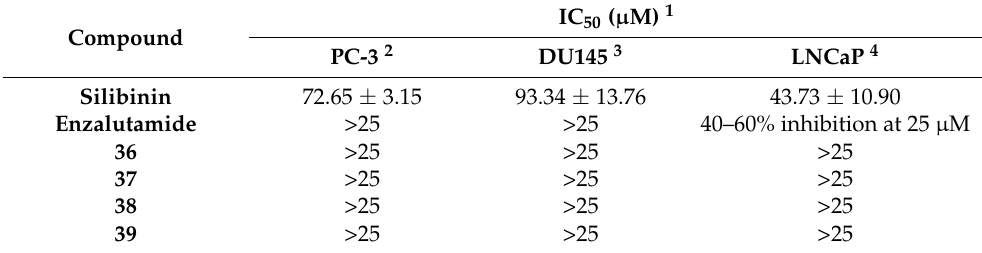
Table 4. Antiproliferative activity of taxifolins.